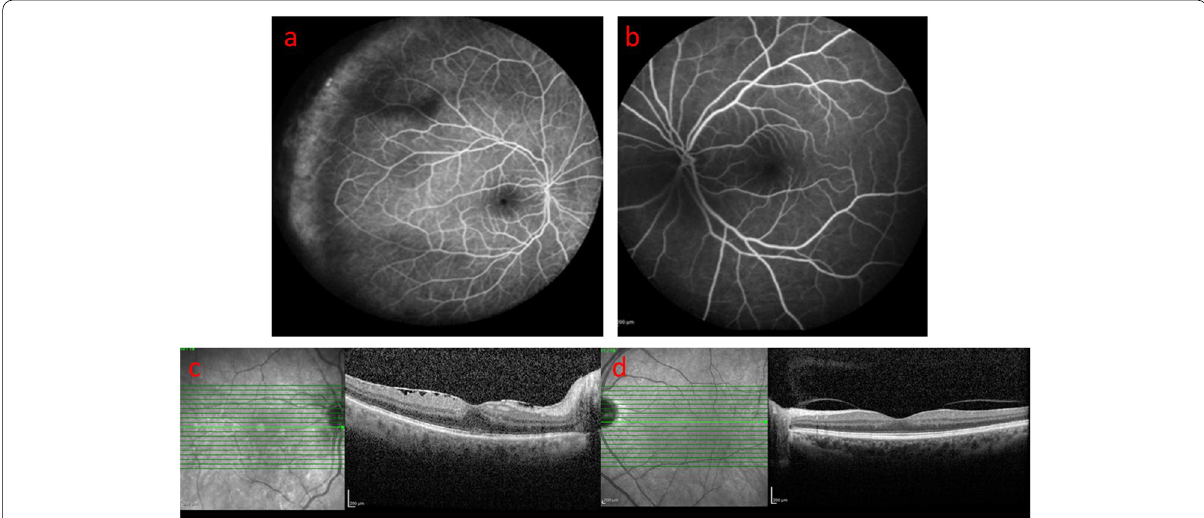
Fig. 4 Six-month after intra-ocular treatment: Fluorescein angiography of the right ( a ) and the left eye ( b ); Macular OCT of the right eye ( c ) disclosed epiretinal membrane and normal choroid and normal left eye ( d